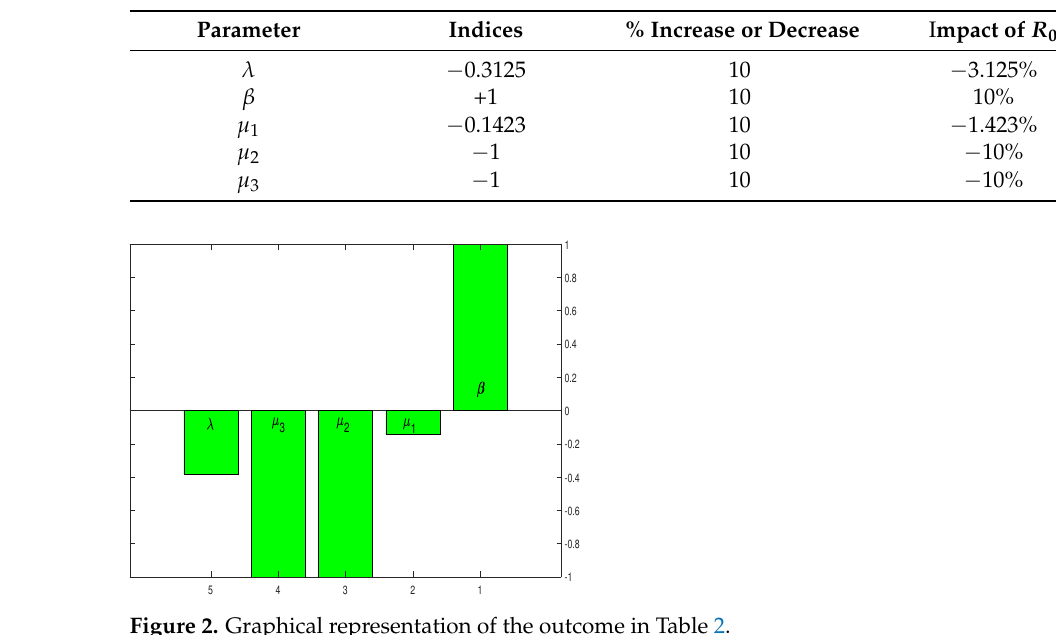
Table 2. The parameters and the associated sensitivity indices along with the relative percentage impact on the threshold quantity ( R 0 ).